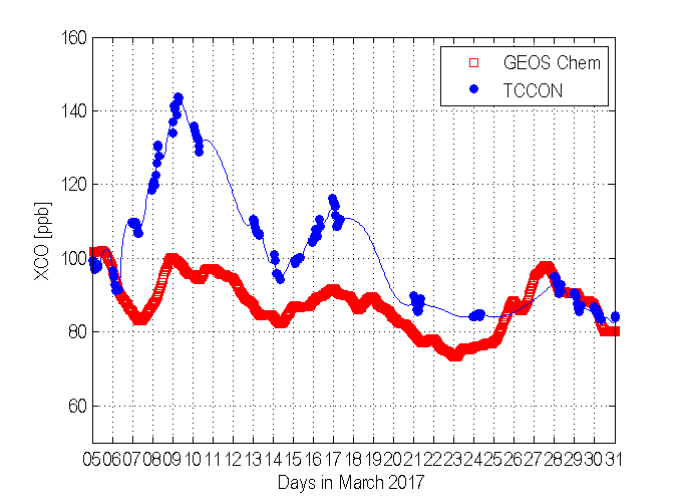
Figure 7. TCCON measurements of X CO ( blue ) and the corresponding model simulations ( red , offset applied).